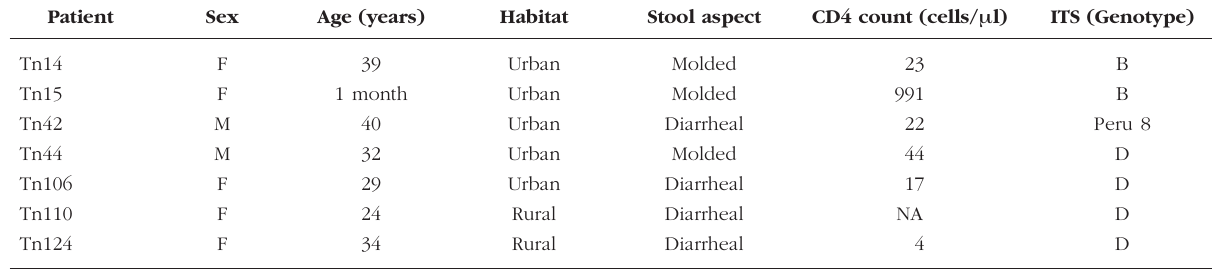
Table I. – Clinical and epidemiological data of patients with Enterocytozoon bieneusi